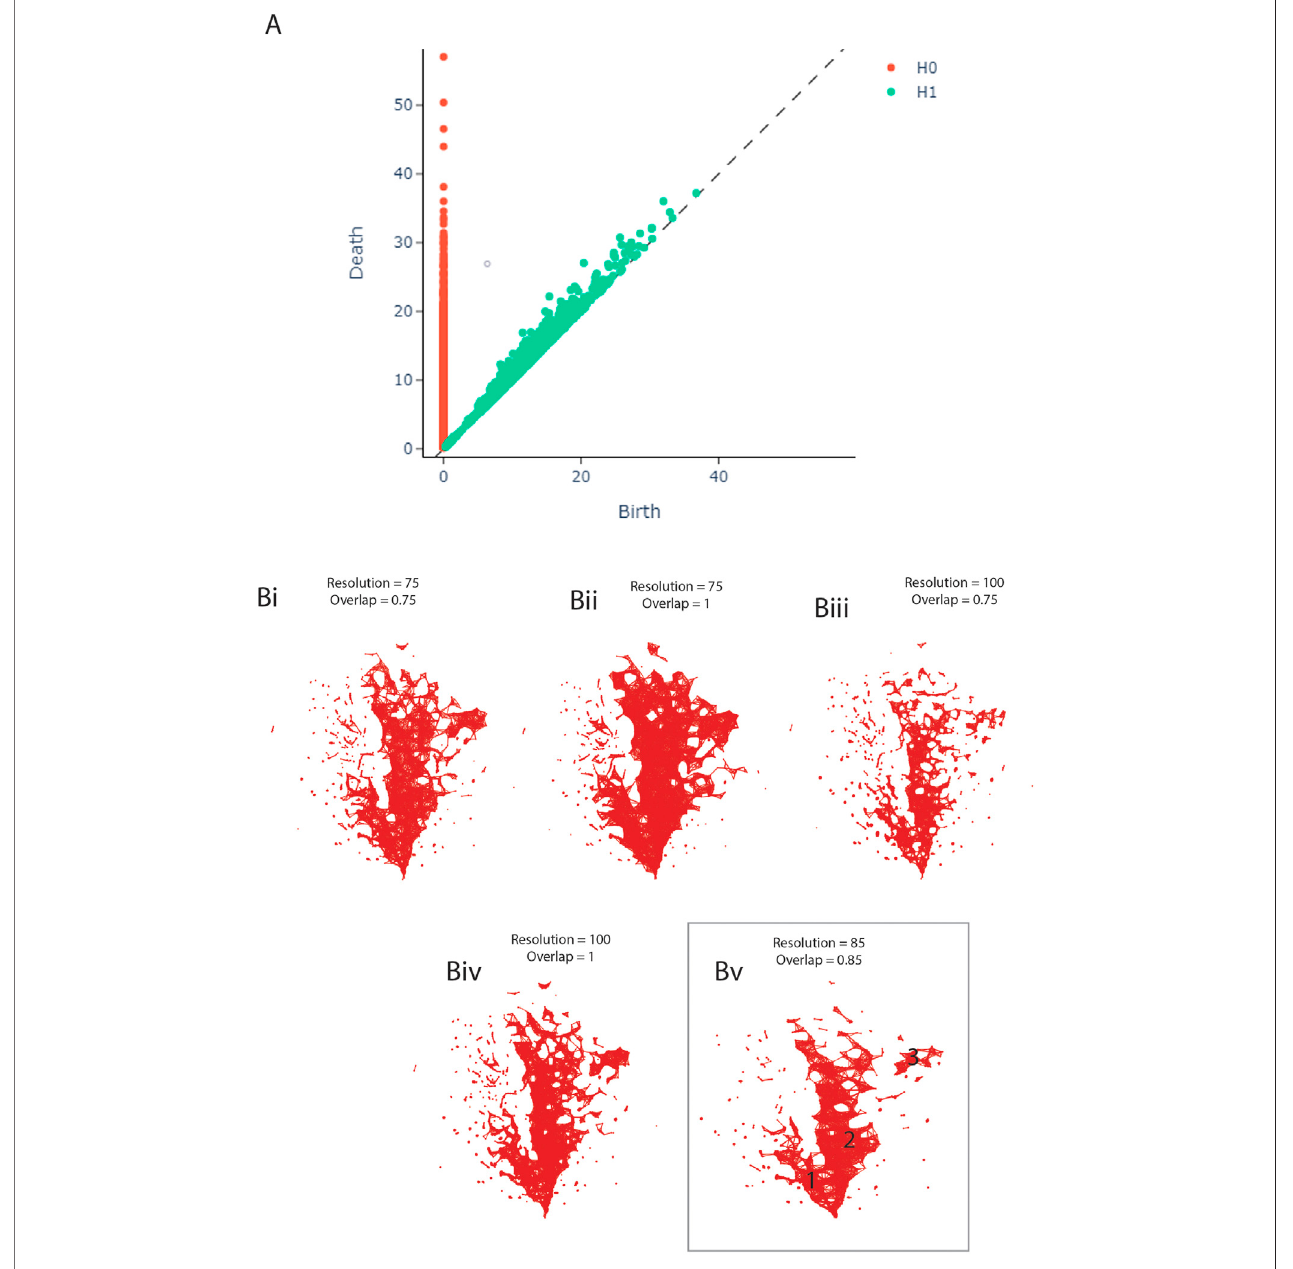
FIGURE 1 | (A) Persistence Diagram. (B) Adjusting the resolution and overlap parameters of the TDA network to achieve optimal cover ratio. Bv shows the fi nal network, including the three